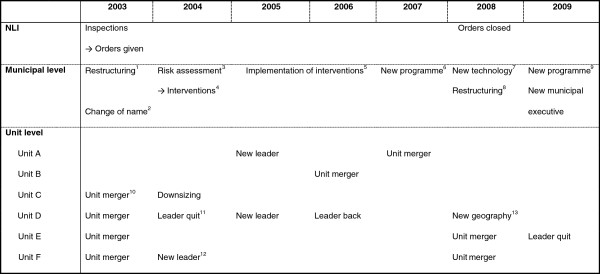
A chronological timeline of significant events taking place in the municipality from 2003 to 2009. Note: 1Separating home help (practical tasks) from home care resulting in pure professional caring tasks. 2Change of name from “Health and care services” to “Health and welfare services”. 3Risk assessment resulting in 4interventions as described in Method section. 5Implementation of interventions on municipal level affecting all units included the establishment of a safety patrol, temporary staff recruitment service and staff uniforms. Implementation at unit level involved improved work routines and organization of work, more equipment and facilities etc. 6Quality-enhancing work programme involving specification of new work duties and responsibilities concerning the everyday life of patients living at home. 7Introduction of a Personal Digital Assistant involving changes in work procedures, acquiring of new skills etc. 8Assisted living institutions separated from the Home Care Services resulting in pure home care. 9Quality-enhancing work programme involving specification of new work duties and responsibilities concerning patients’ discharge from hospital and return to home. 10Unit mergers in all cases involved new work office, leader, colleagues, geographical area, care recipient group, budget figures, work routines, organizational culture etc. 11Leader quitting in all cases involved a turbulent period of stand-in leaders before the hiring of 12new leader. 13New geography involved new patients and greater geographical distances of transferring.